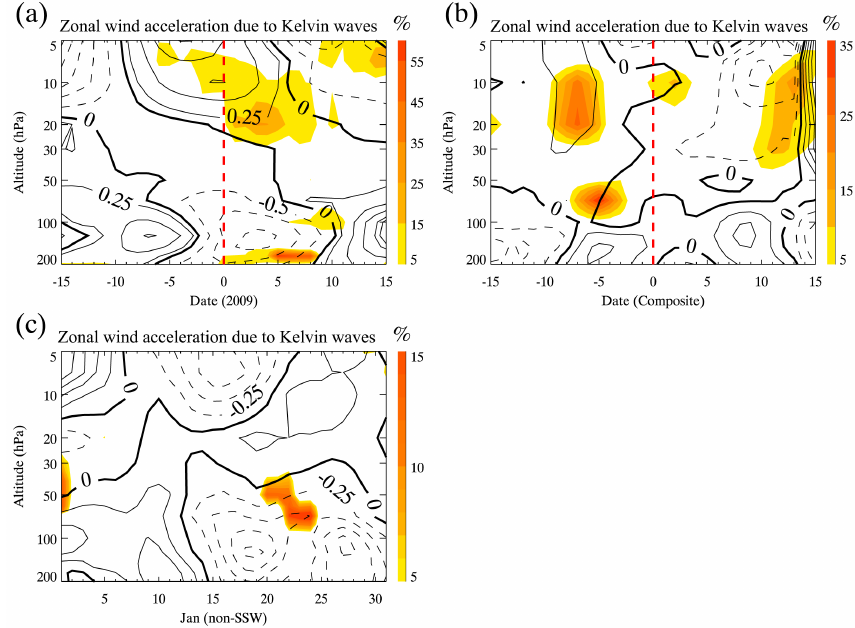
Figure 9. Altitude time cross section of relative contributions of Kelvin wave acceleration to zonal wind acceleration during (a) 2009 SSW event, (b) the composite event, and (c) January without SSWs derived from ECMWF data. The relative contributions are presented in percent, and only positive values are shown. The tropical zonal wind anomalies of each event are overplotted, solid contours represent eastward anomalies, the dashed contours represent westward. Bold contours represent zero